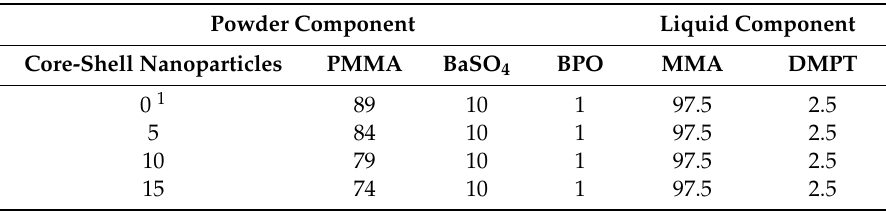
Table 1. Bone cement formulations.